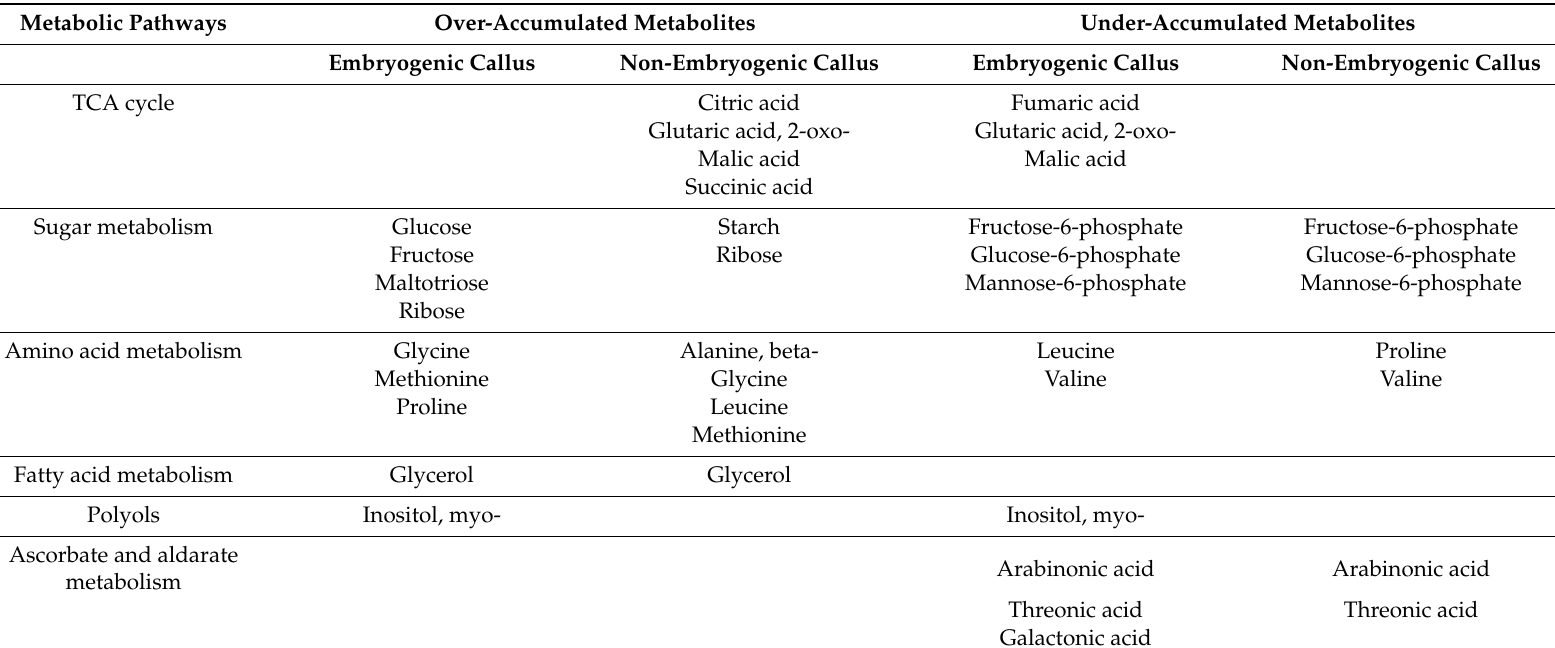
Table 6. Over-accumulated and under-accumulated metabolites in embryogenic and non-embryogenic